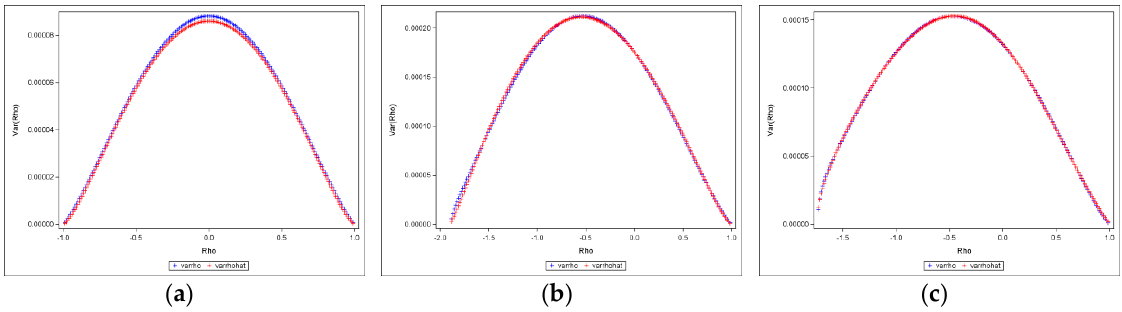
Figure 4. Fitted curves of the asymptotic variance versus ˆ ρ for 150-by-150 ( n = 22,500 ) adjacencies: ( a ) square rook case; ( b ) square queen case; and, ( c ) hexagonal case.